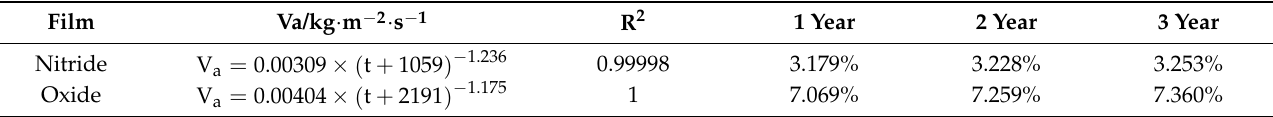
Table 7. Fitting formula of different films and prediction of hydrogen loss in 1–3